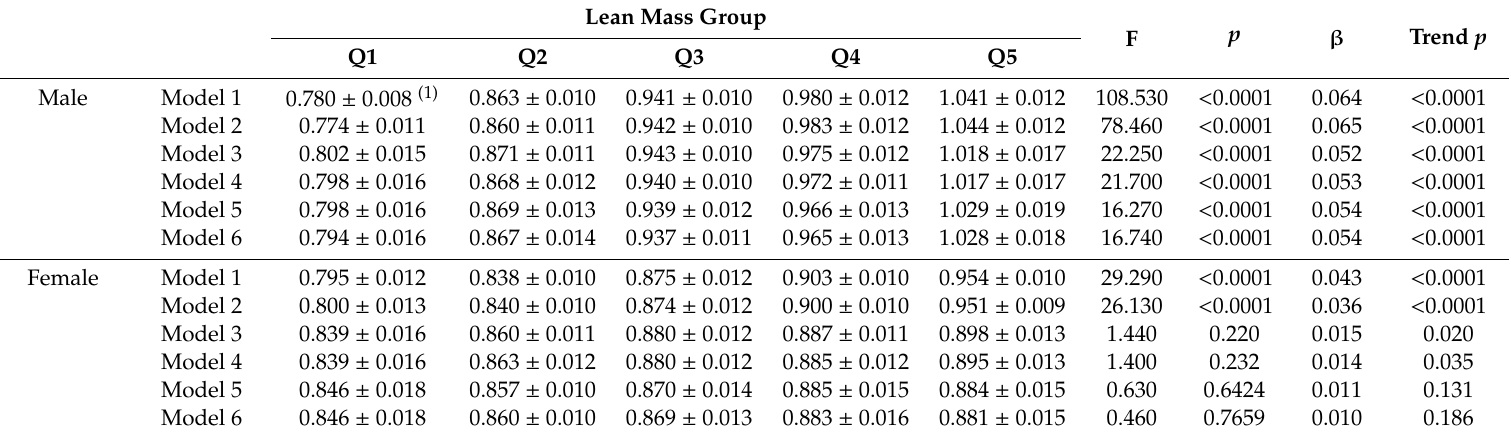
Table 4. Analysis of the bone density (total femur) di ff erences of lean mass